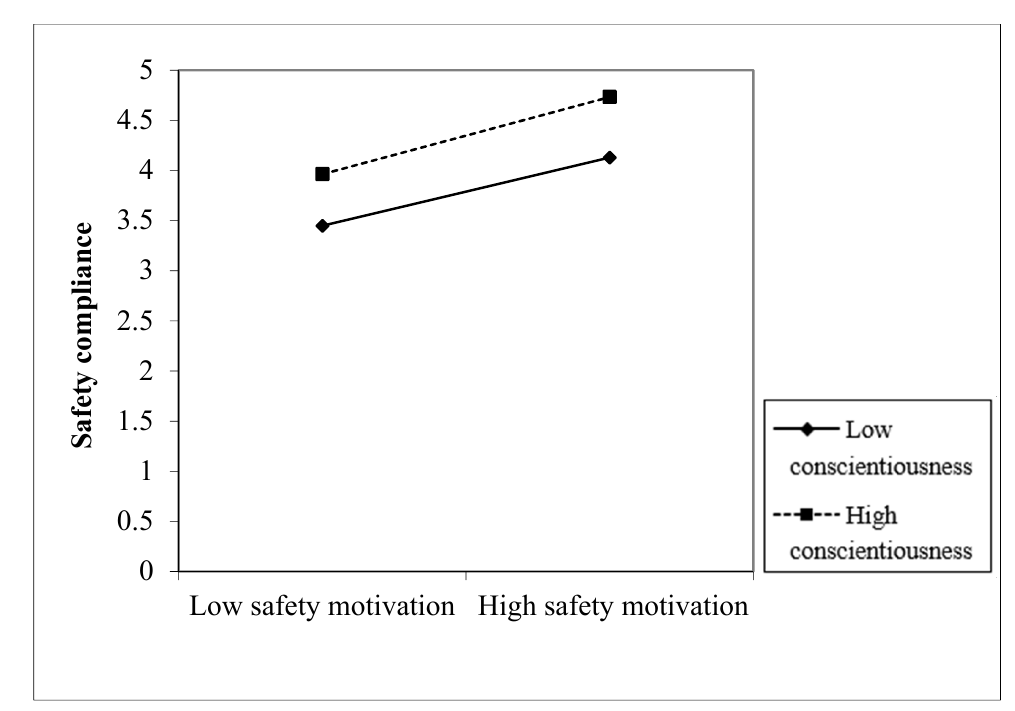
Figure 2. Interaction between safety motivation and conscientiousness on safety compliance.